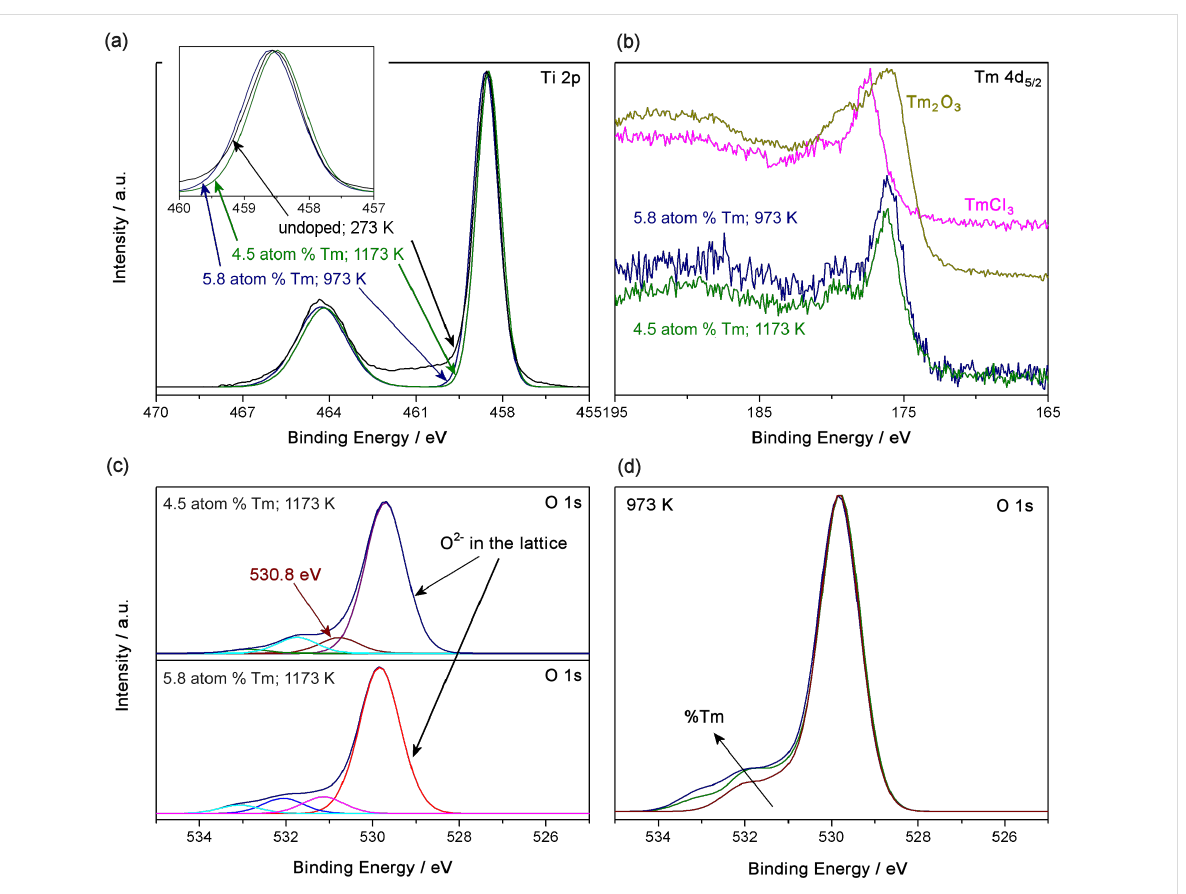
Figure 2: XPS spectra of Ti 2p (A); Tm 4d 5/2 (B); O 1s including contributions of different O in the samples (C) and O 1s versus percentage of Tm